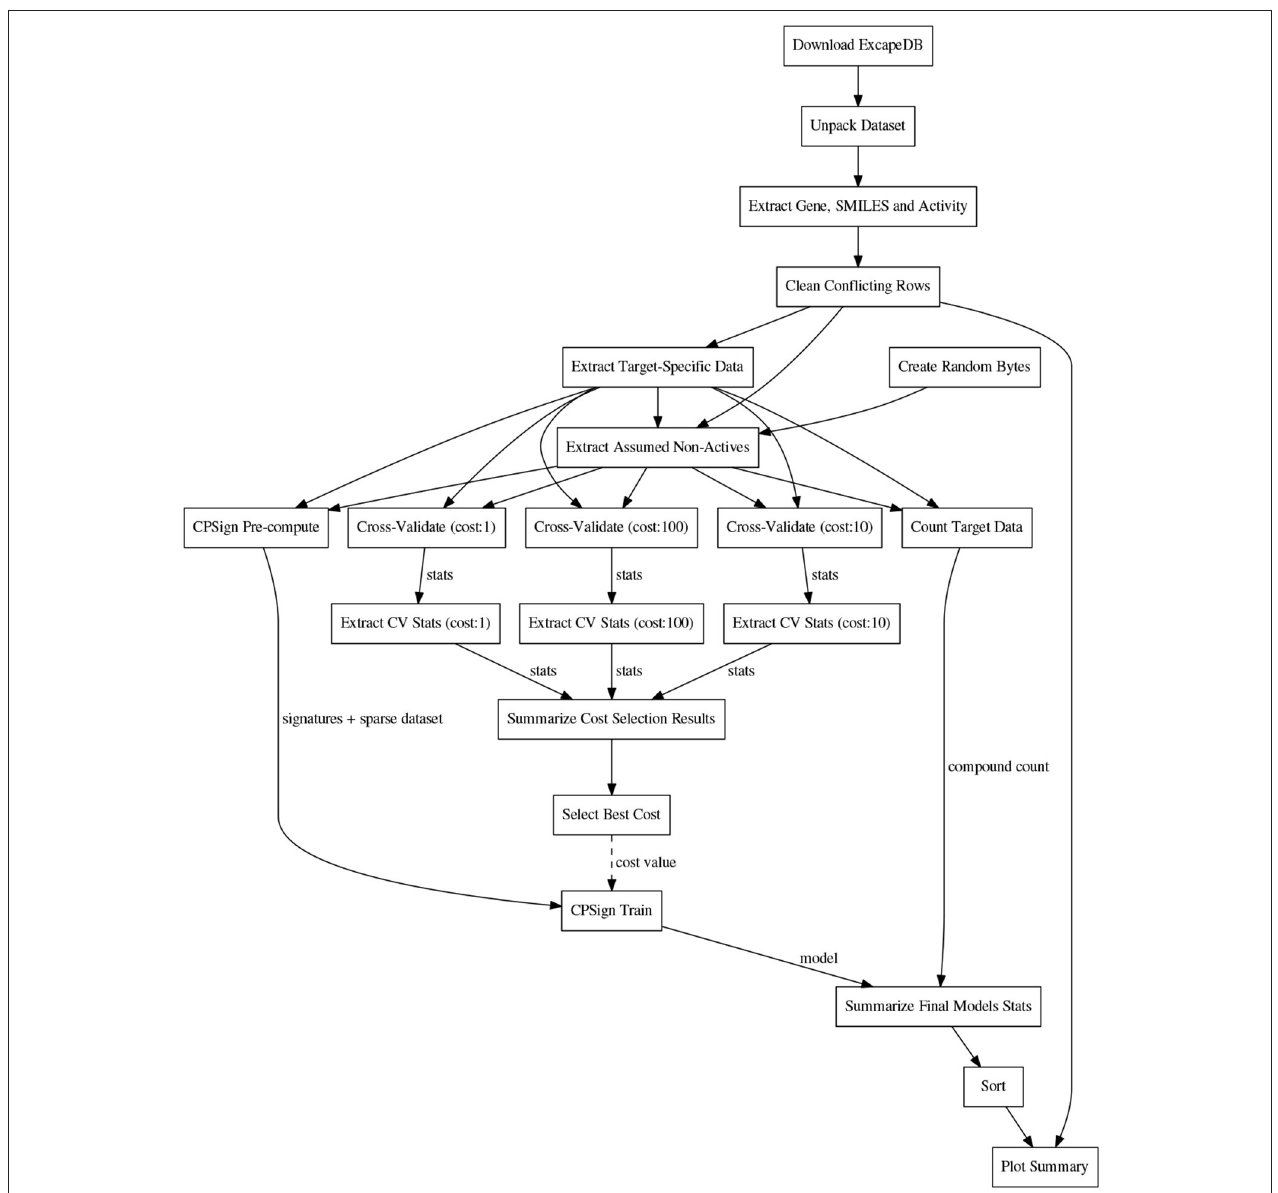
FIGURE 2 | Schematic directed graph of processes and their data dependencies in the modeling workflow used in the experiments in this study. Boxes represent processes, while edges represent data dependencies between processes. The direction of the edges show in which direction data is being passed between processes. The order of execution is here from top to bottom, of the graph. Each experiment contains additions and modifications to the workflow, but the workflow shown here, exemplifies the basic structure, common among most of the workflows. For more detailed workflow plots, see Supplementary Data Sheet 1 , Figures S4 , S5